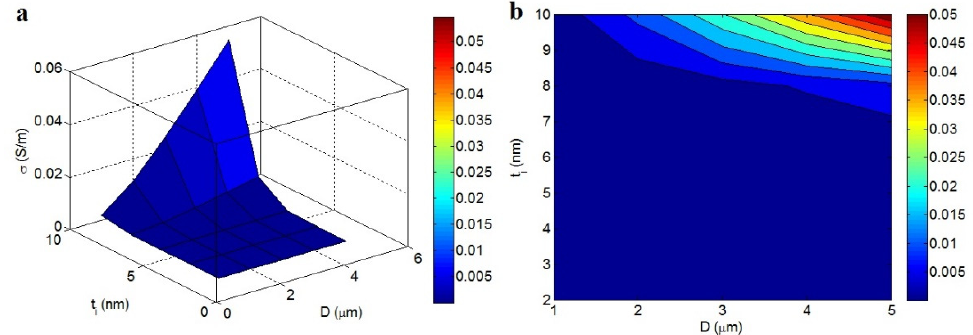
Figure 4. Effects of D and t i on the predicted conduction using Equation (14): ( a ) 3D and ( b ) 2D pictures.